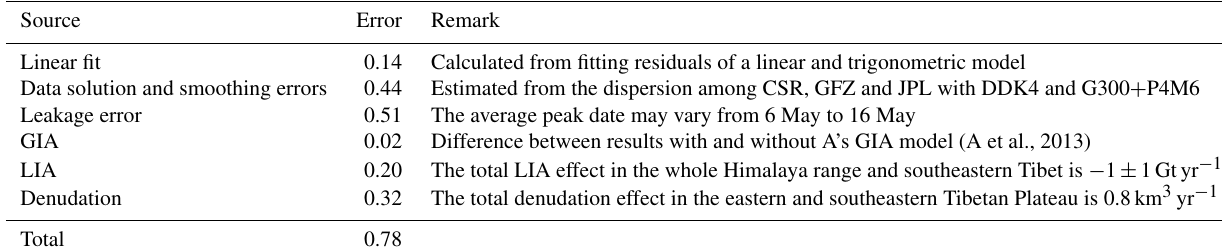
Table 2. GRACE error sources for the long-term trend (Gtyr − 1 ). Source